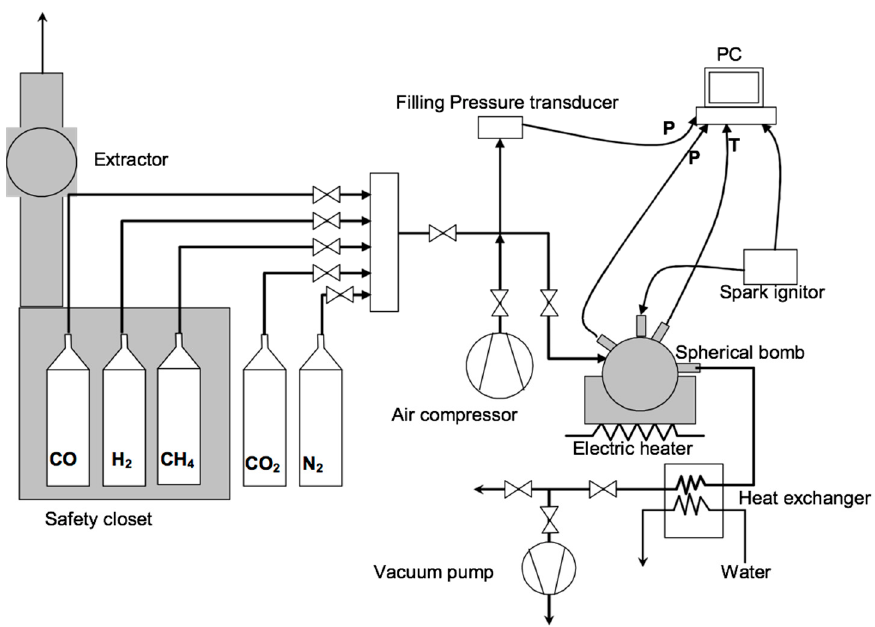
Figure 1. Experimental facility.